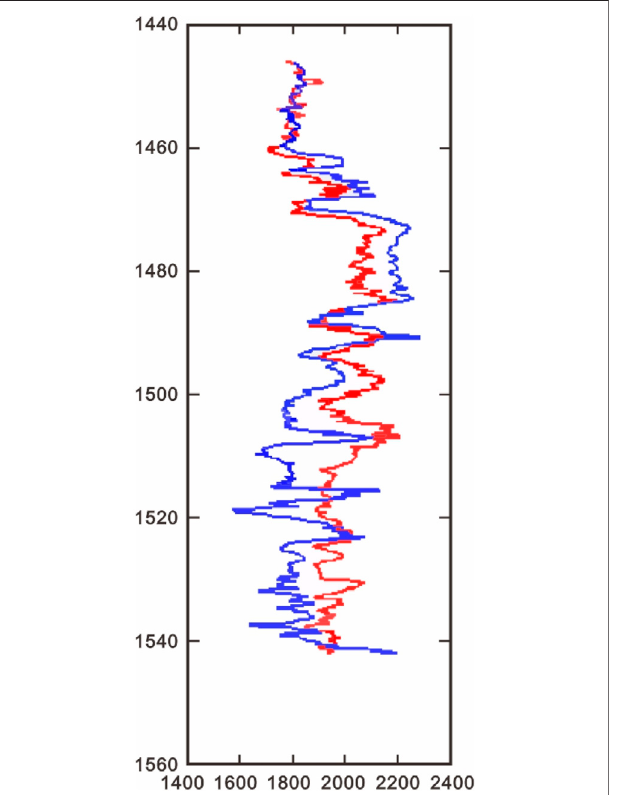
FIGURE 4 | P-wave velocity prediction results of well A.